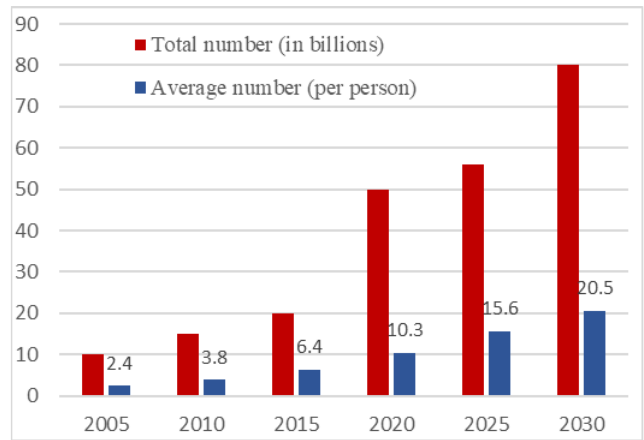
Figure 1. Number of connected IoT devices (2005~2030).